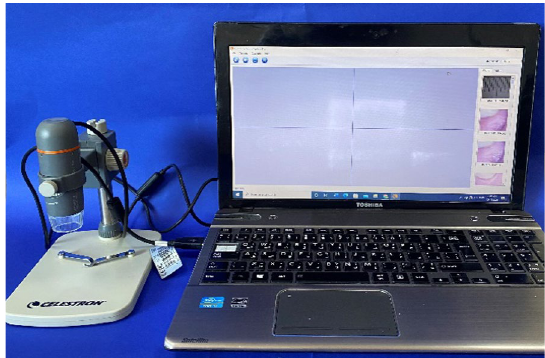
Fig. 4 Hand-held Celestron digital microscope connected to the computer